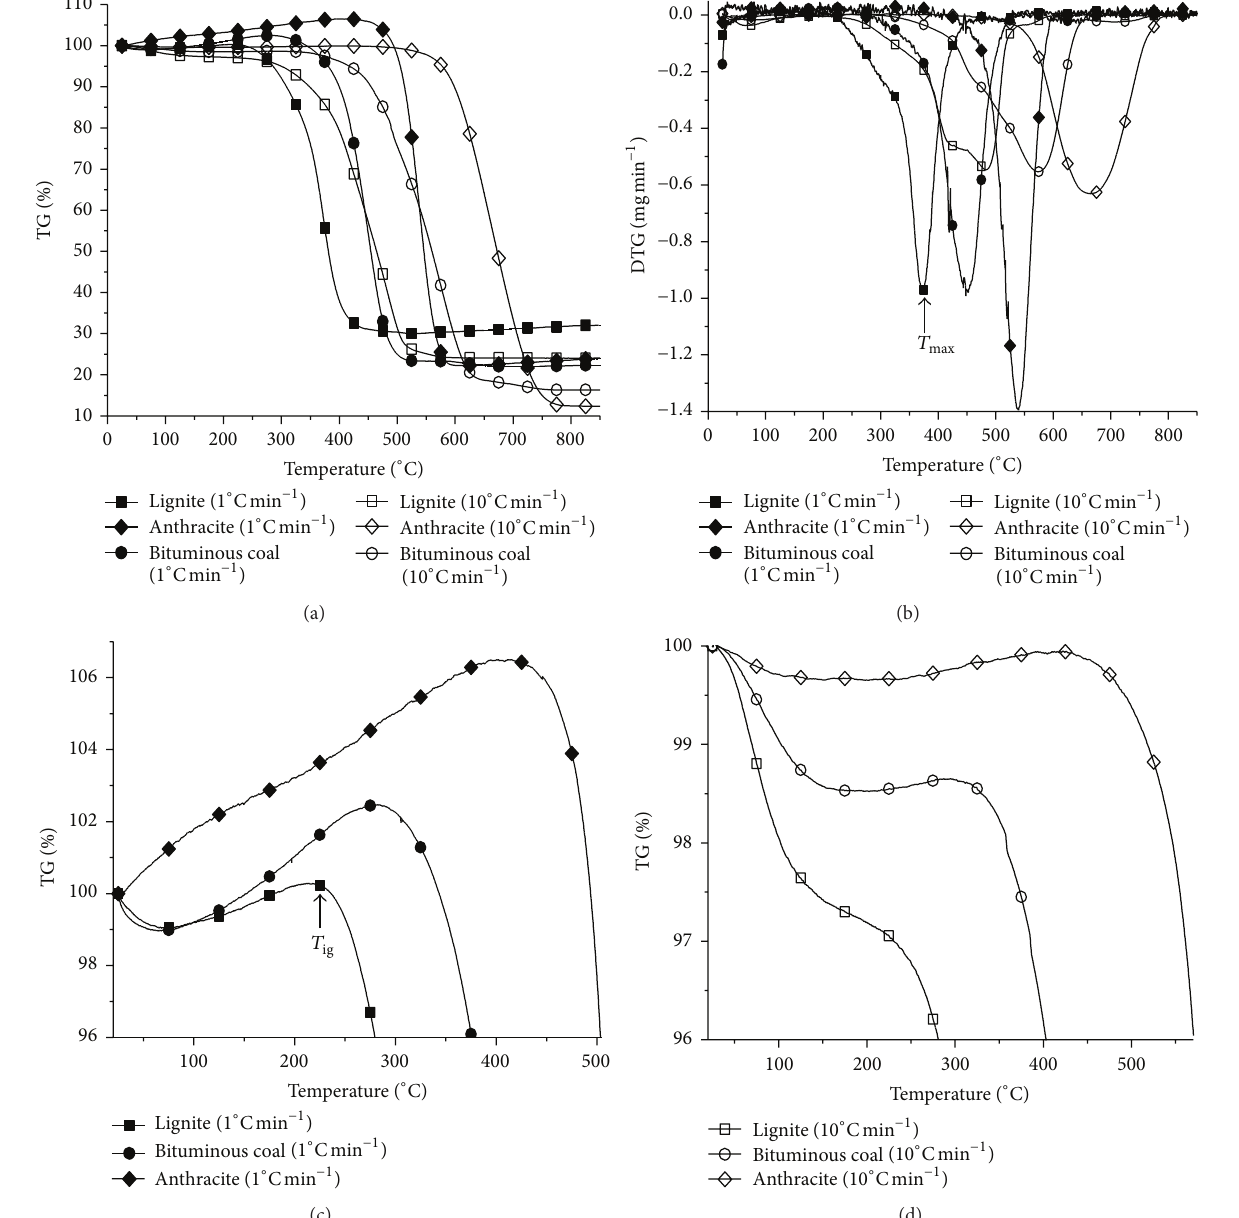
Figure 3: (a) TGA results of the coal samples. (b) Differential TGA (DTG) of the coal samples. (c) TGA over the range of 96–107% mass change at 1 ∘ Cmin −1 . (d) TGA over the range of 96–100% mass change at 10 ∘ Cmin −1